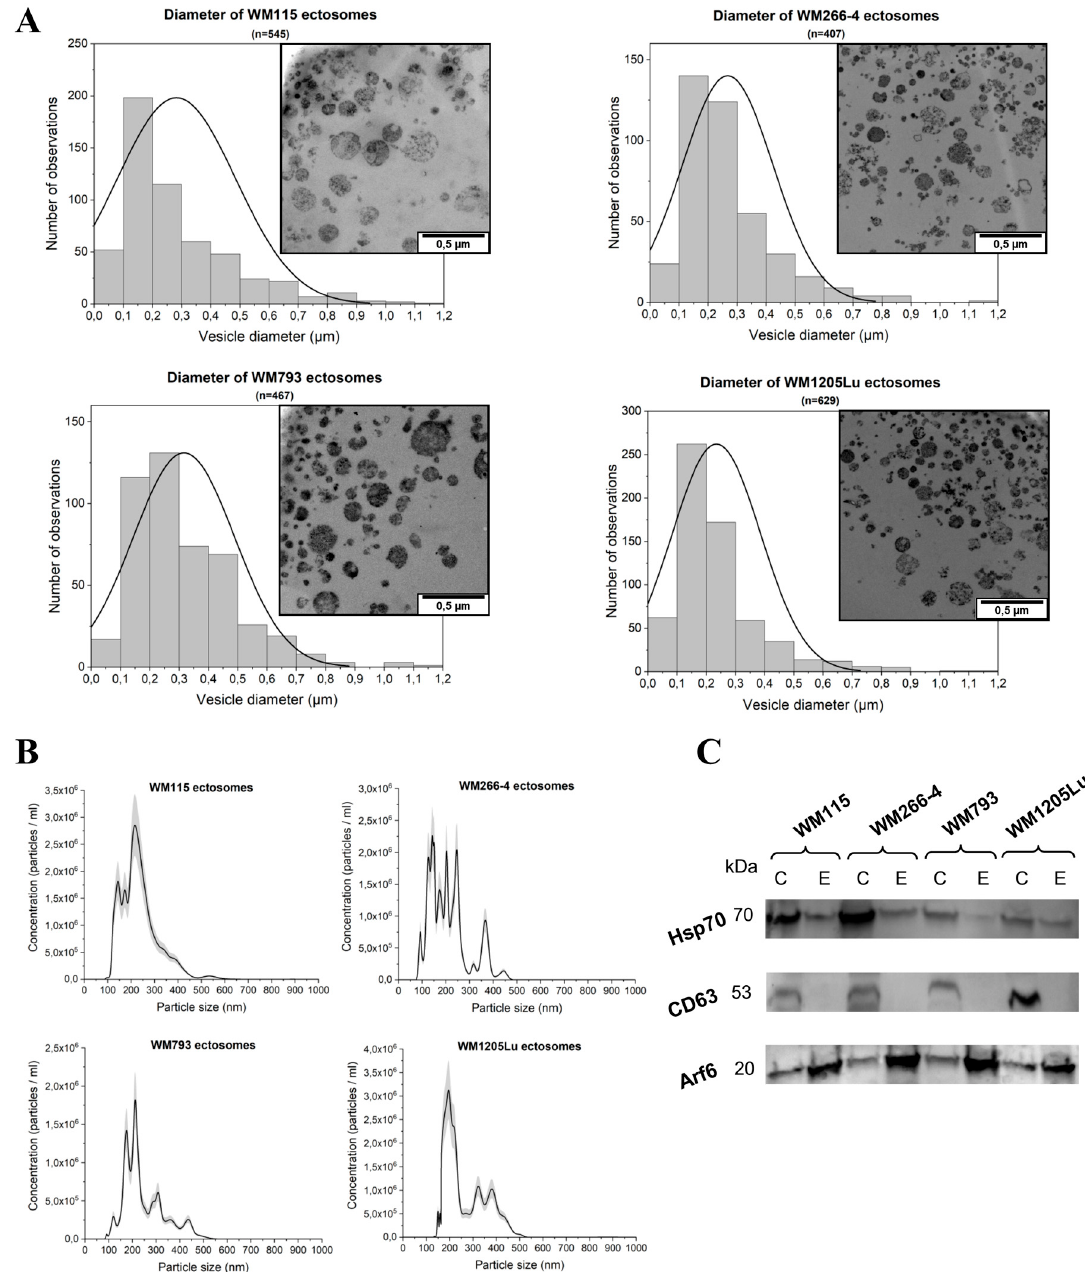
Figure 1. Analysis of ectosome sample purity. ( A ) TEM analysis of cutaneous melanoma (CM)-derived ectosomes. Size distributions are presented on histograms. Mean diameter ± standard deviation was calculated for all observed vesicles (n) from a given sample. ( B ) Nanoparticle Tracking Analysis (NTA) analysis of CM-derived ectosomes. Results from five independent measurements for each CM cell line are presented on graphs. The shaded area depicts standard deviation. ( C ) Western blot analysis of extracellular vesicle (EV) markers. Fifty µ g of proteins from whole-cell protein extracts (lines C) and ectosome samples (lines E) separated by 10% SDS-PAGE and transferred into PVDF membrane were probed with anti-CD63 (1:2000), anti-HSP70 (1:2000) and anti-ARF6 (1:500) as primary antibodies and anti-mouse IgG-HRP (1:400) as a secondary antibody. WM115 (primary) and WM266-4 (metastatic), cell lines originating from the same individual, radial / vertical growth phase and lymph node metastasis, respectively; primary WM793 cell line, representing the vertical growth phase; WM1205Lu, a metastatic variant of WM793 cells obtained from lung metastasis.